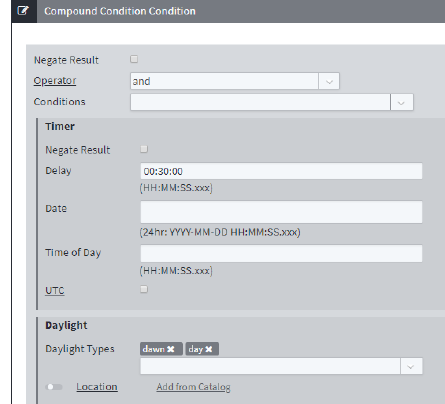
Figure 4: Timer and daylight condition to trigger disaster